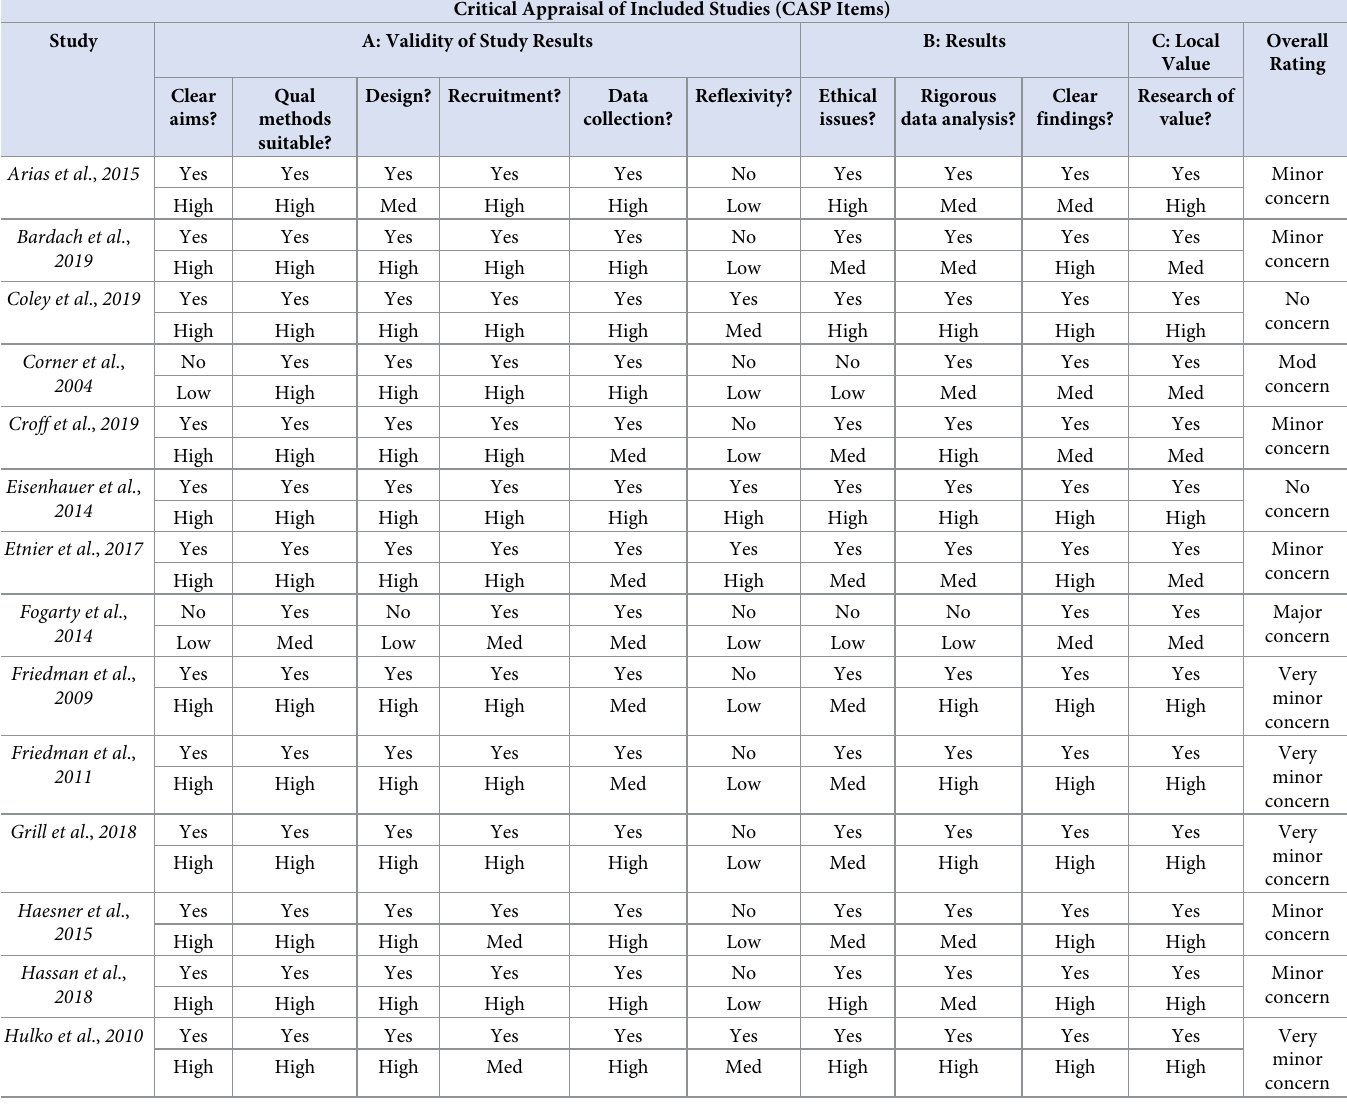
Table 2. Quality appraisal for included